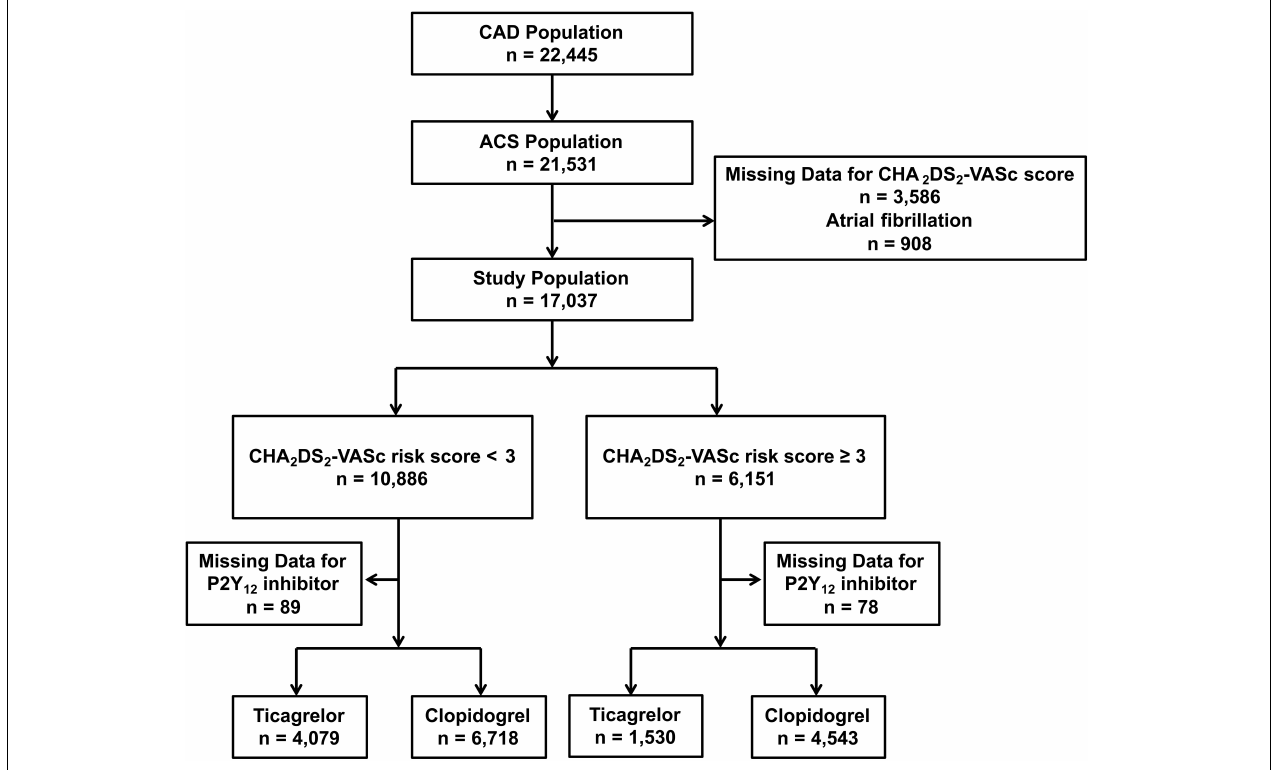
FIGURE 1 | Flow chart of the study